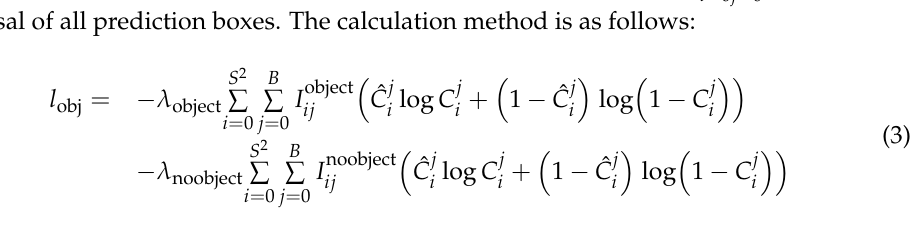
S indicates deter- j = 0